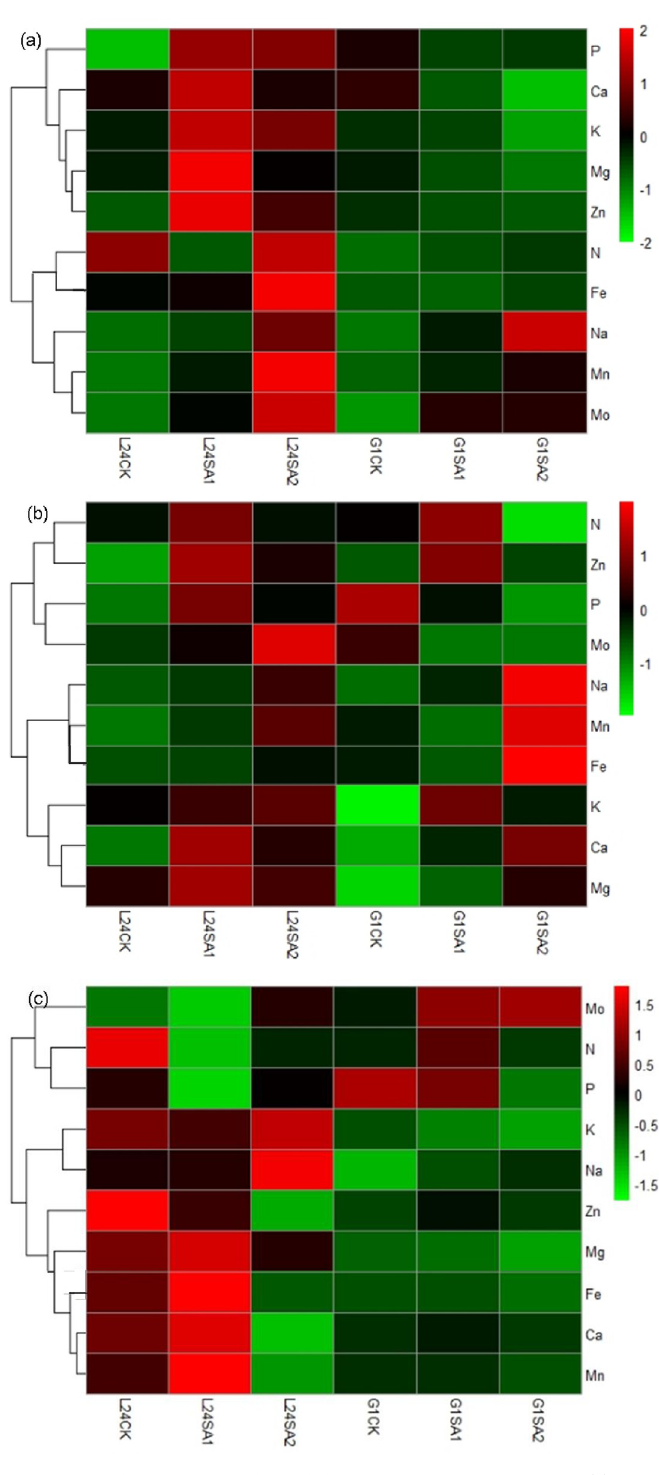
Fig 6. Hierarchical cluster analysis of element concentrations in leaves (a), stem (b), and root (c) of two cotton varieties (salt-tolerant variety L24, salt-sensitive variety G1) under saline-alkaline stress (SA1, SA2). The abscissa represents the sample name, and the ordinate represents the elements. Different columns in the figure represent various samples, and rows represent element concentrations. The color represents the level of element concentrations in the